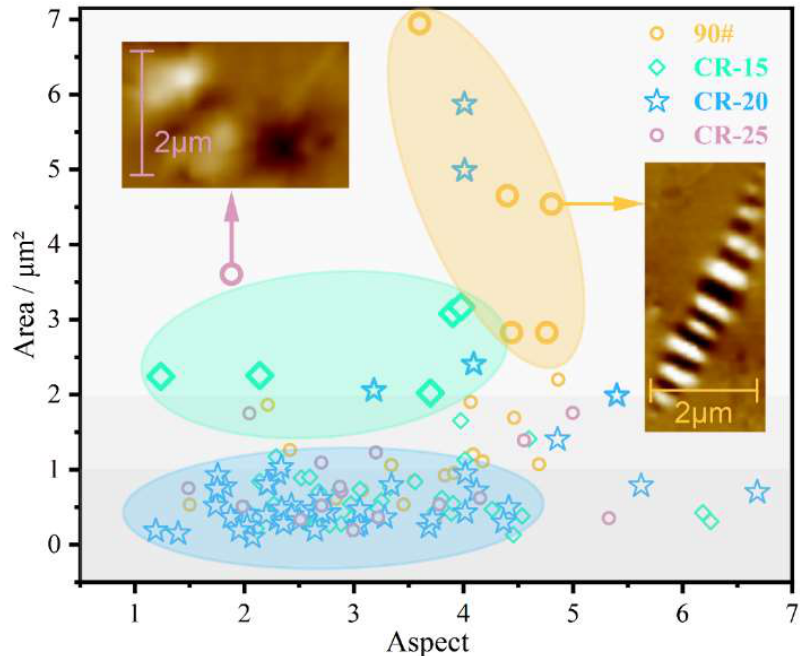
Figure 12. Morphological transformation of the catanaphase.